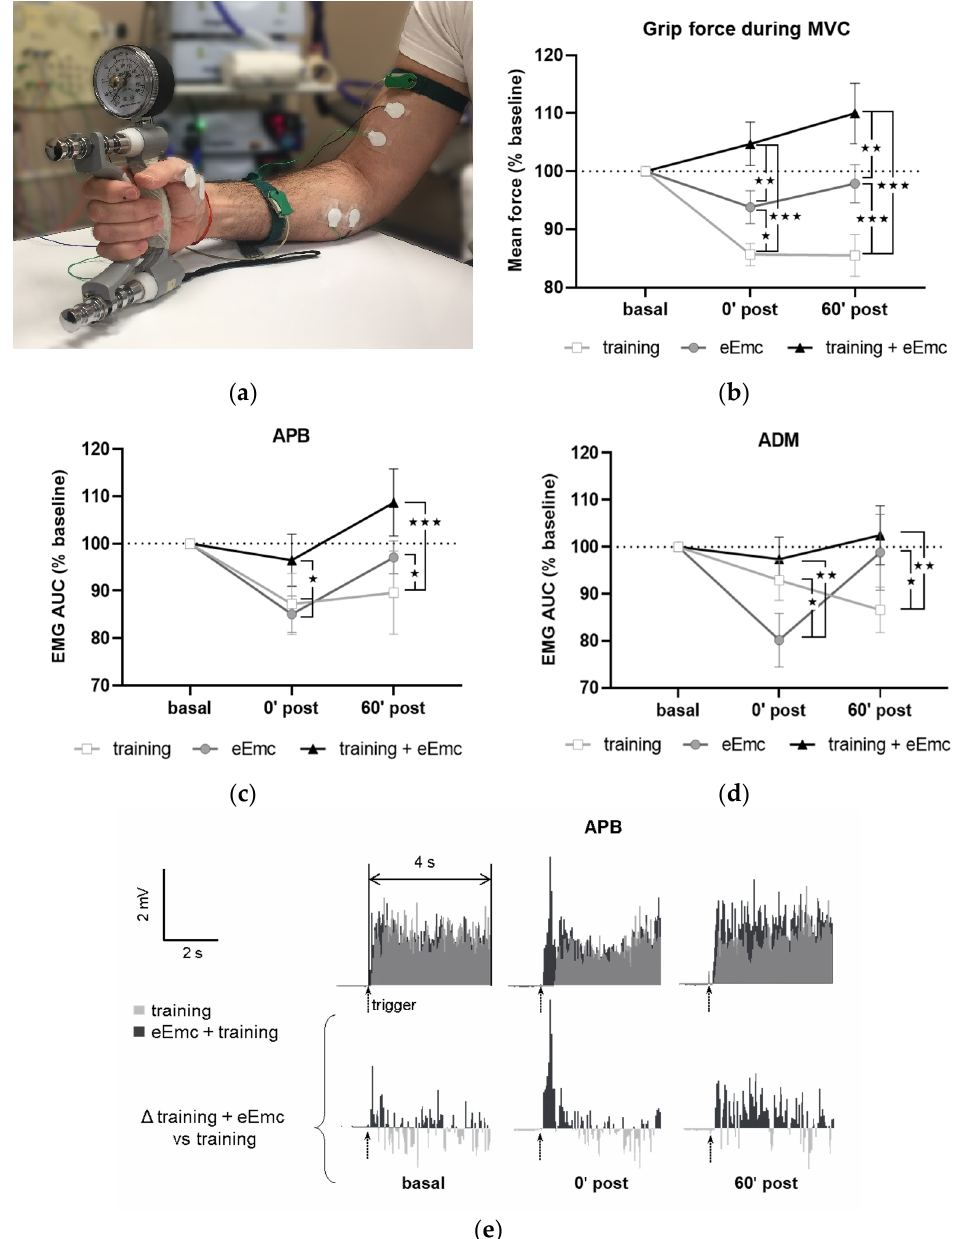
Figure 2. Maximal voluntary contraction (MVC) during hand grip strength. ( a ) Picture showing general setting and position for hand grip MVC assessment. ( b ) Percentage of MVC vs. baseline levels at 0 min (0 (cid:48) post) and 60 min (60 (cid:48) post) after each intervention. Significant differences between interventions: (cid:70) p < 0.05, (cid:70)(cid:70) p < 0.01, (cid:70)(cid:70)(cid:70) p < 0.001. ( c , d ) Percentage of area under the curve (AUC) of electromyographic (EMG) activity vs. baseline levels from APB ( c ) and from ADM ( d ). Significant differences between interventions: (cid:70) p < 0.05, (cid:70)(cid:70) p < 0.01, (cid:70)(cid:70)(cid:70) p < 0.001. ( e ) Representative APB muscle EMG registry (obtained from subject #5) corresponding to maximum voluntary contraction (MVC) trials during training and eEmc with training interventions at basal, 0 (cid:48) and 60 (cid:48) after intervention. Upper panels correspond to rectified values, and lower panels show difference between registers of both interventions for better difference appreciation. APB, abductor pollicis brevis; ADM, abductor digiti